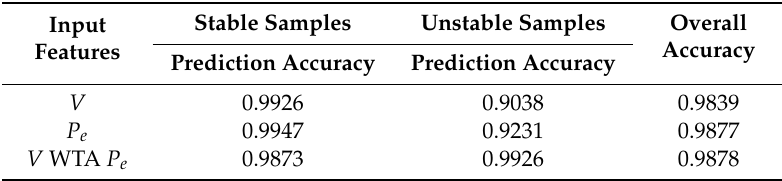
Table 6. The prediction accuracy of di ff erent prediction